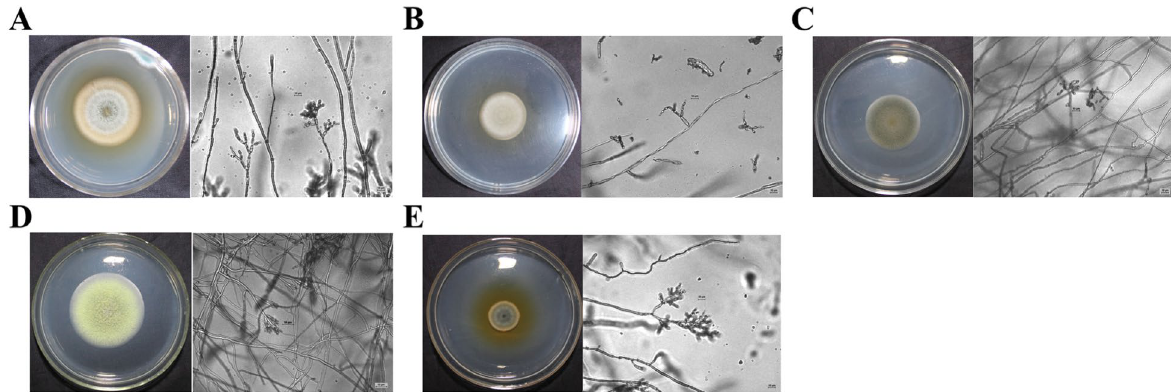
Fig. 3 Single colony morphology and microstructure (mycelia and spores) of culturable fungi from water samples. The fungi were inoculated onto the PDA medium and incubated at 28° C for 3 days. The scale is 10 μm. A Cladosporium sp. (NH.I-F1). B Cladosporium sp. (NH.I-F2). C Cladosporium sp. (NH.I-F3). D Penicillium sp. (NH.P-F1). E Cladosporium sp. (NH.A-F1). Bar 10 µm =